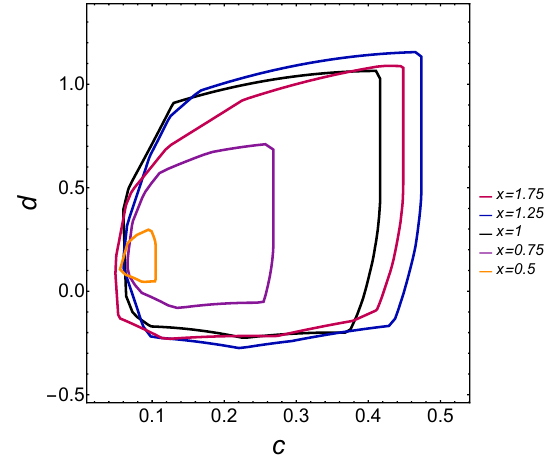
Figure 5 . Positive regions in the ( c, d )-plane with different x (the regions within the solid lines are allowed by generalized elastic positivity bounds) in the Z κ 3 = 1 . 4 , κ 4 = 0 . 38 , λ = 0 . 2 and 1 / 2 < x < 2 .